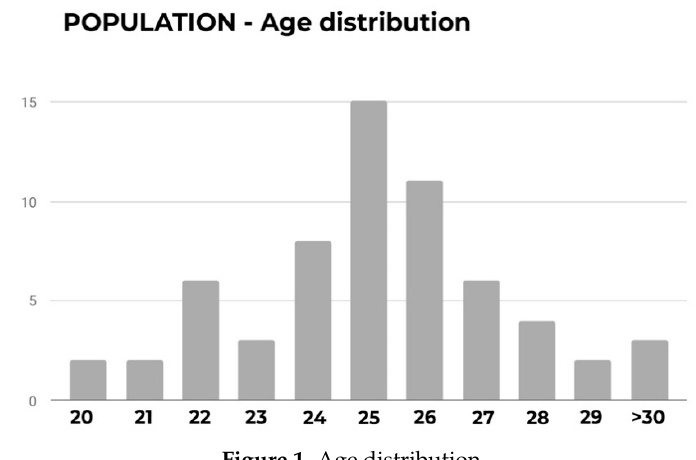
Figure 1. Age Figure 1. Age distribution.